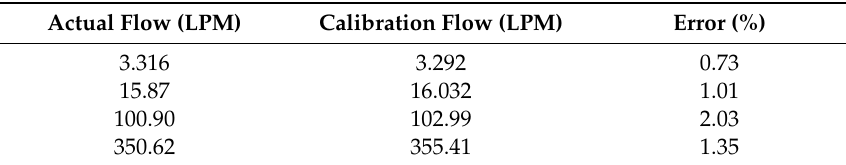
Table 2. Results from the flowmeter